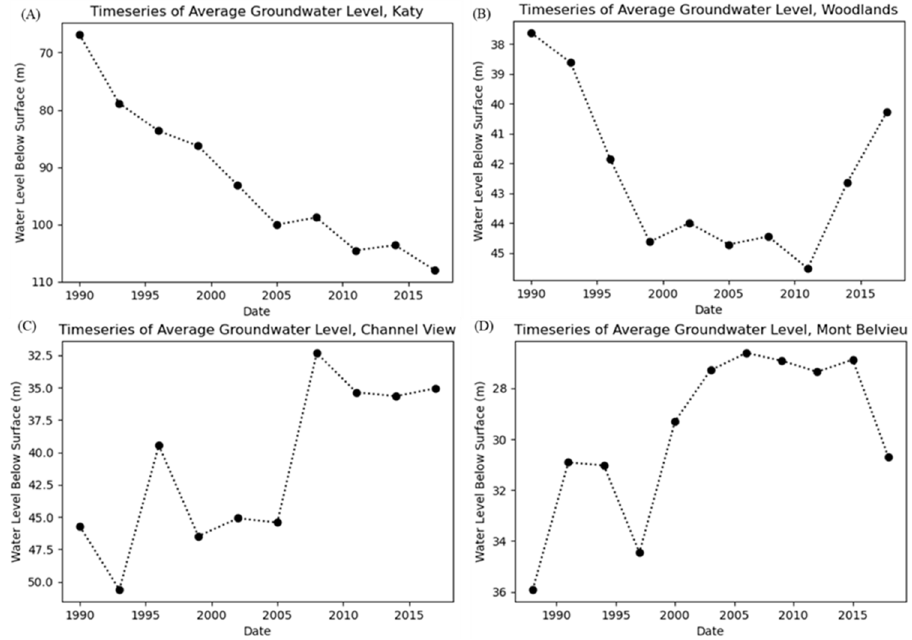
Figure 9. Groundwater level change time series for areas with high subsidence rates. Data derived from the groundwater well analysis from 1990 to 2021 for ( A ) Katy, ( B ) the Spring–Woodlands area, ( C ) Channelview, and ( D ) Mont Belvieu.